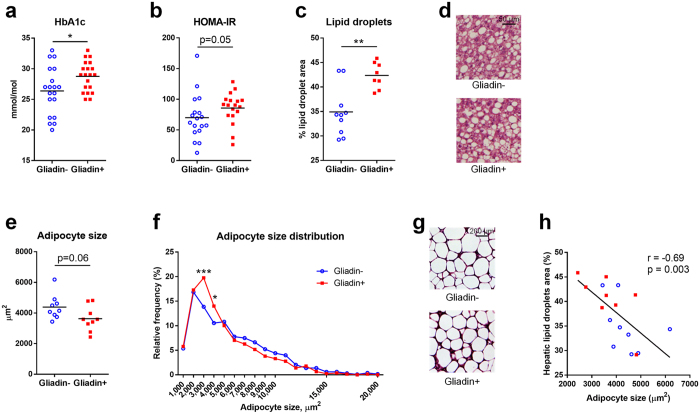
Gliadin affected glucose homeostasis, liver lipid accumulation and adipocyte size in eWAT.Mice were fed HFD (60% energy originating from fat) with gliadin (Gliadin+, n = 20) or without (Gliadin−, n = 19) for 23 weeks and subjected to measurements of metabolic features at termination. Panel (a) shows HbA1c levels in blood, (b) HOMA-IR, (c) percentage of lipid droplet area of the liver (each data point represents the average of six squares of 40,000 μm2), (d) hematoxylin- and eosin-stained hepatic sections, e the median adipocyte size of four different adipose tissue sections, (f) the relative frequency of the mean adipocyte size of four different adipose tissue sections, (g) hematoxylin- and eosin-stained eWAT sections, and h Spearman correlation between adipocyte size in eWAT and total lipid droplet area in the liver. In panels (a–c) and (e), horizontal lines represent the means, while asterisks represent statistically significant differences between the two feeding groups (*p < 0.05, **p < 0.01, unpaired t test or Mann-Whitney test). In panel (f), asterisks represent false discovery rate (FDR) corrected p values71 from multiple t tests (*q < 0.05, ***q < 0.001). In panel (h), the p value and r coefficient of Spearman correlation are listed, and the linear regression line is shown. In panels (c–h), n = 9–10 mice per group. See also Supplementary Fig. S1 and Supplementary Table S2.